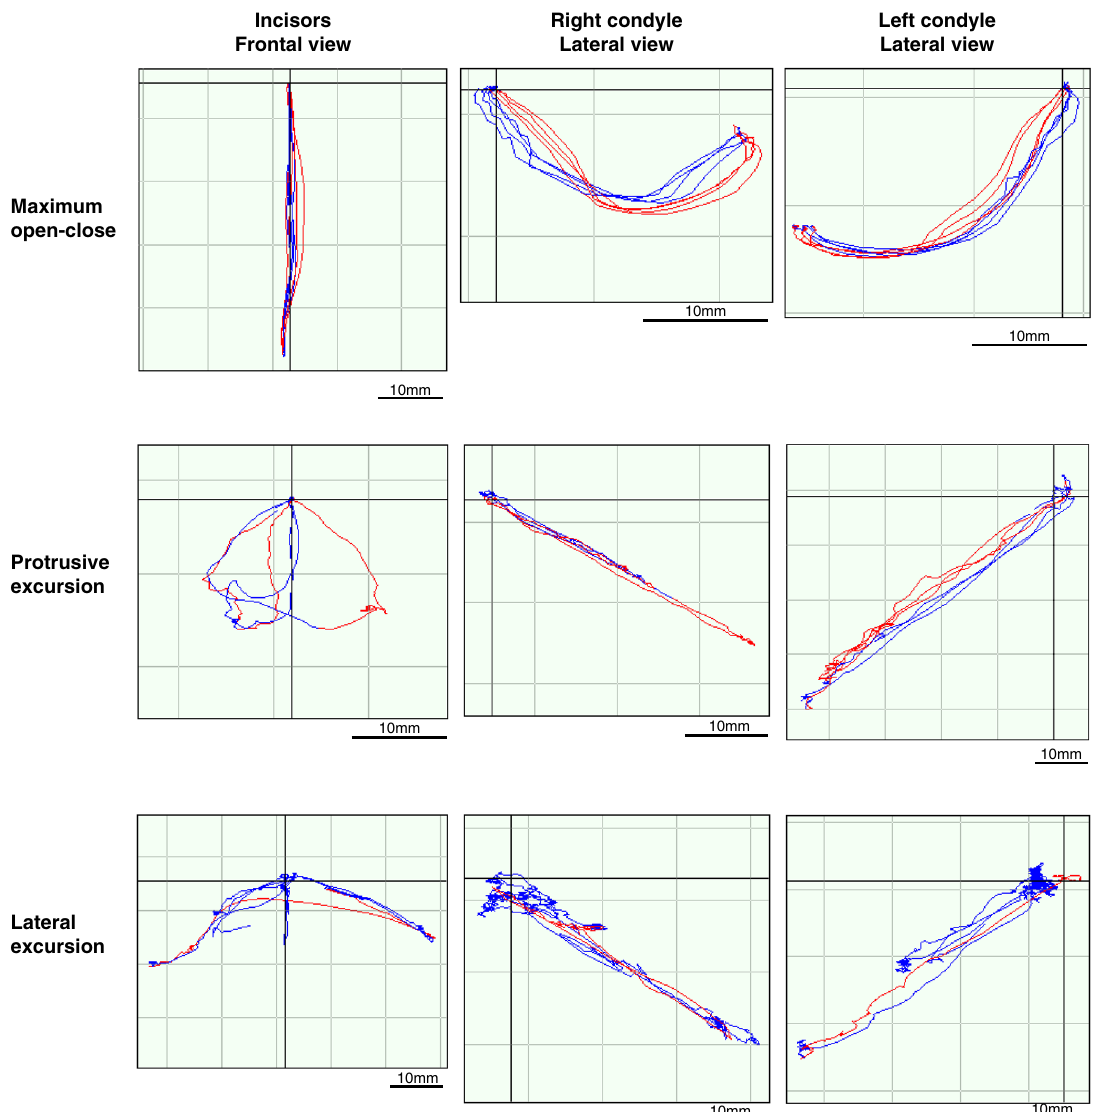
Figure 11. Posttreatment condylar movements and incisal paths as detected using a 6 degrees of freedom jaw movement recording system. Opening and closing, protrusive, and lateral jaw movements. The red line indicates the opening phase, and the blue line indicates the closing